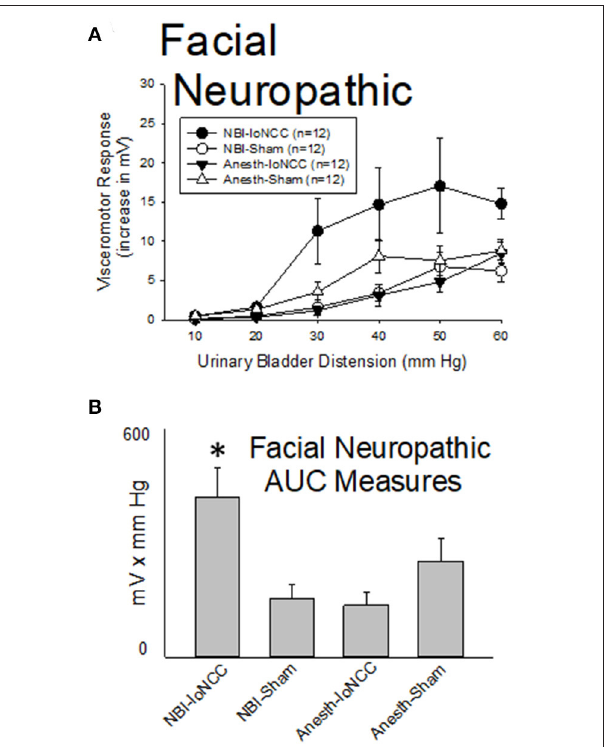
FIGURE 7 | Hindpaw Inflammation Augments VMRs in Rats Which Experienced NBI. Presentation is similar to that of Figures 2 – 5 (group stimulus-response functions in (A) ; Area-Under-the-Curve, AUC, measures in (B) ). Rats which had experienced NBI demonstrated statistically greater VMRs to UBD compared with controls when presented with hindpaw inflammation induced by the injection of Complete Freund’s Adjuvant (CFA) as a second insult as adults. “VEH” indicates vehicle injection into the hindpaw as an adult control procedure. *indicates VMRs in the NBI-CFA group was statistically more robust than all other groups ( p < 0.05). See text for greater explanation and analysis.